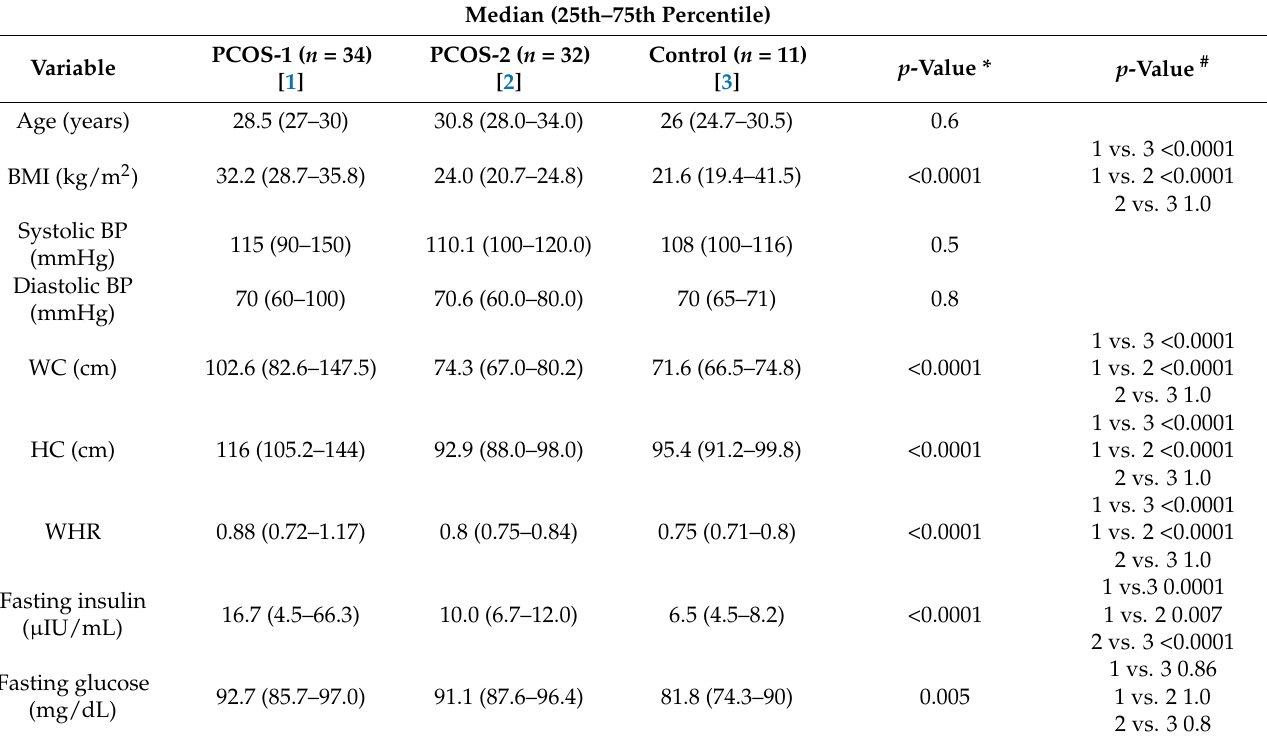
Table 2. Characteristic and comparison PCOS-1 vs. PCOS-2 vs.